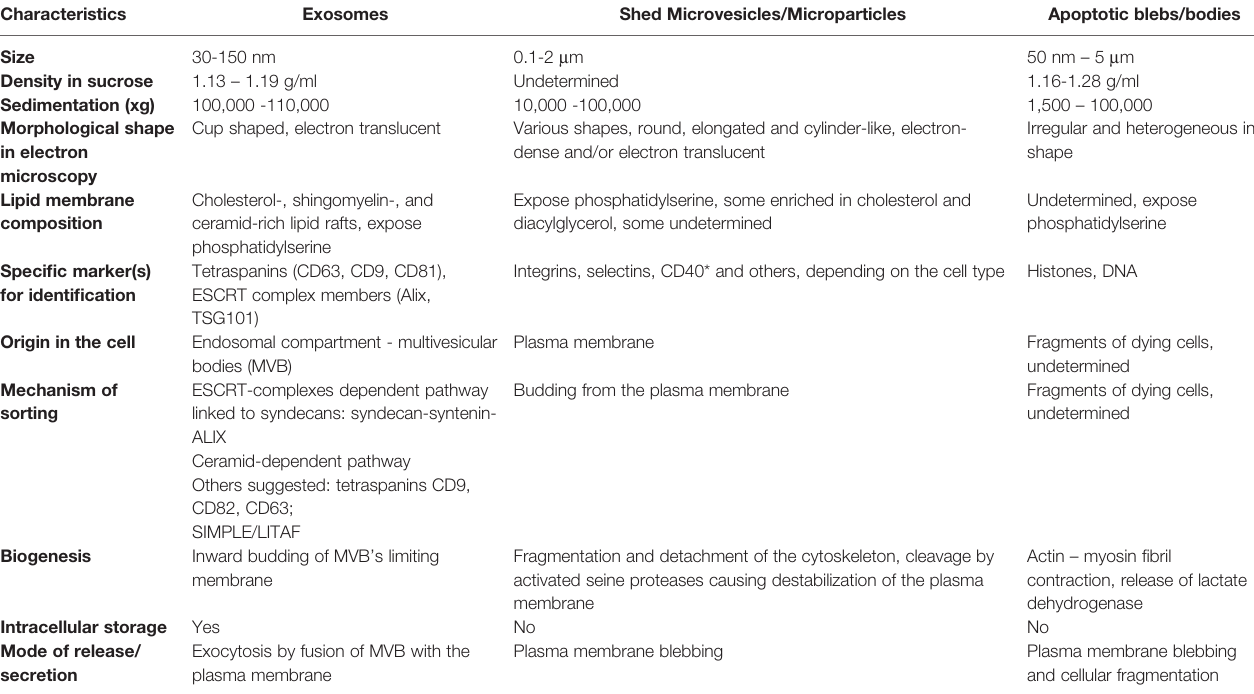
TABLE 1 | Some characteristics of extracellular vesicles produced by human syncytiotrophoblast [modi fi ed from ref. (11)].